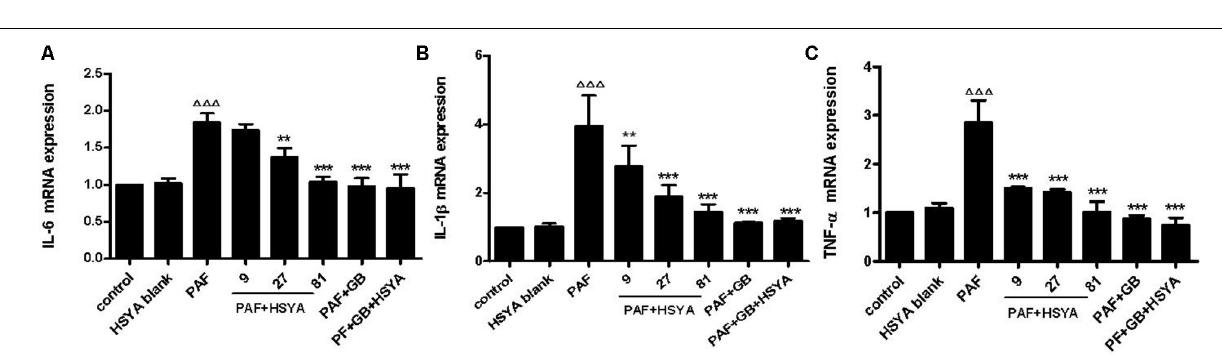
FIGURE 2 | High-performance liquid chromatography analysis of purified HSYA. The absorbance was measured at 405 nm (20-min peak is HSYA).